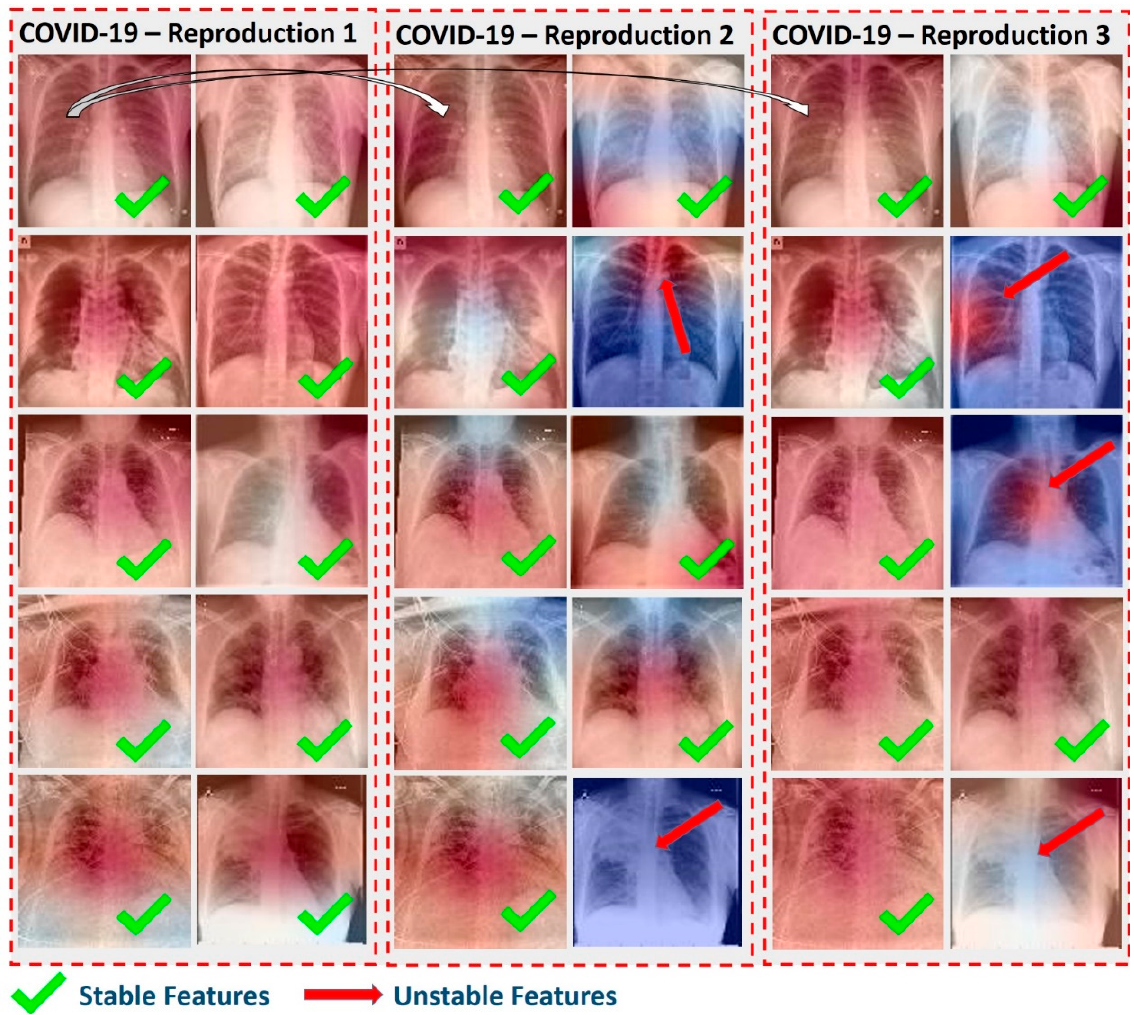
Figure 7. Reproducibility of test methodology.